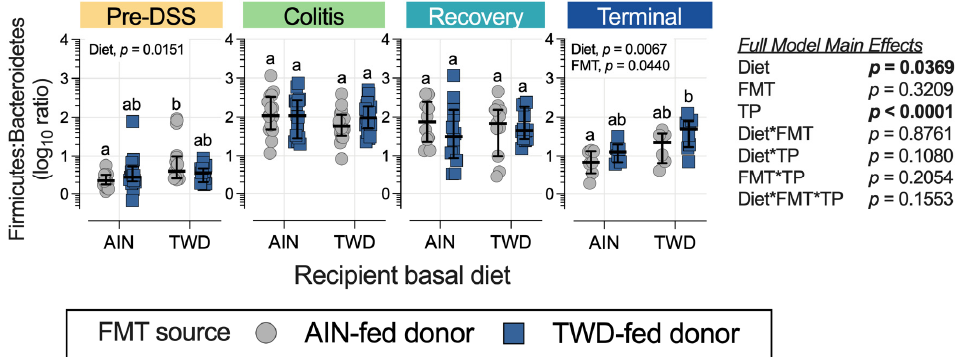
Figure 9. Ratio of Firmicutes to Bacteroidetes at each experimental time point. The ratios were determined using normalized count data for each phylum. The data are shown as individual values representing each cage (as the biological unit) with median ± interquartile range. ( n = 19 to 20 cages per group at the pre-DSS time point, n = 17 to 18 cages per group at the active colitis time point, n = 12 to 13 cages per group at the recovery time point, and n = 7 to 8 cages per group at the terminal time point). The table shows the statistical model’s main effects, including all experimental factors, and different letters indicate that the experimental groups are significantly different ( p < 0.05), as determined by the statistical methods outlined in the Materials and Methods section.